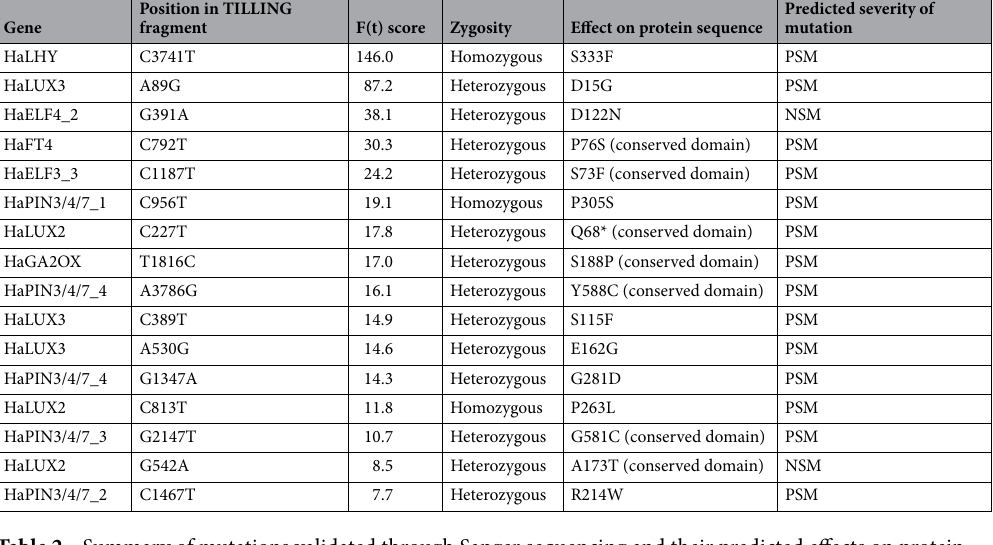
Table 2. Summary of mutations validated through Sanger sequencing and their predicted effects on protein function.